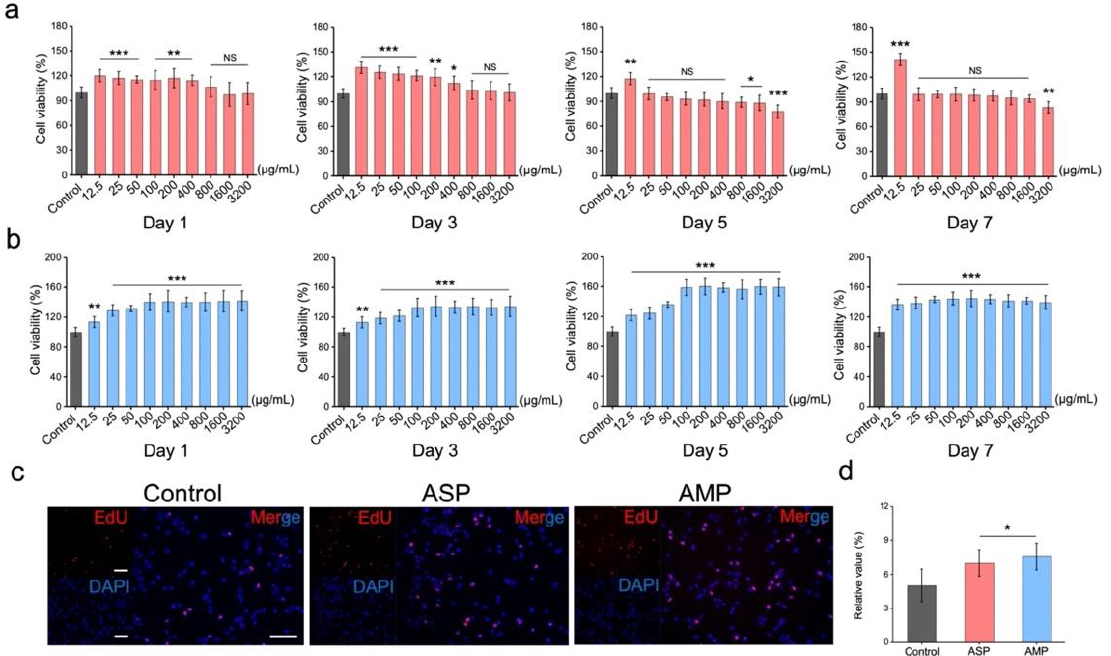
Figure 1. Angelica sinensis polysaccharide (ASP) and Astragalus membranaceus polysaccharide (AMP) promoted proliferation of NCTC clone 1469. The cell viability of hepatocytes treated by various concentrations of ASP ( a ) and AMP ( b ) for 7 days, which was determined by Alamar Blue Cell Viability Reagent ( n = 3). ( c ) Click-iT EdU proliferation staining of hepatocytes treated with ASP and AMP for 3 days (scale bar = 100 µ m). ( d ) Analysis of relative expression rates of positive EdU staining ( n = 3). * p < 0.05, ** p < 0.01, and *** p <